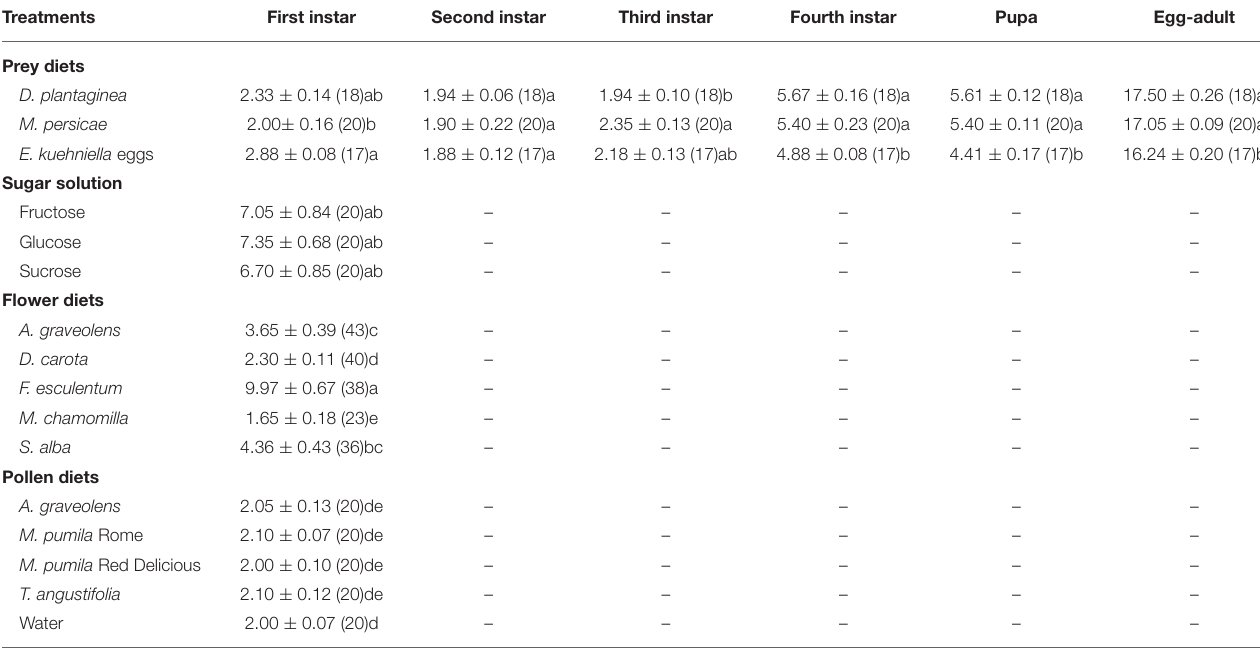
TABLE 2 | Developmental time (days) (mean ± SE) of Adalia bipunctata larvae fed on different diets. Treatments First instar